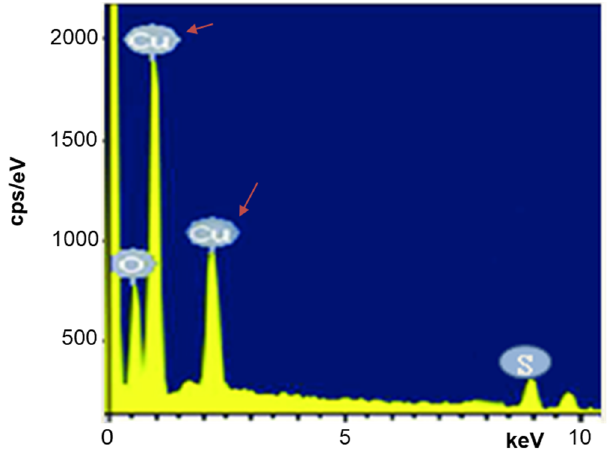
Figure 4. EDAX analysis of green-synthesized CuNPs from star anise showing peaks representing the presence of copper (indicated by arrows).